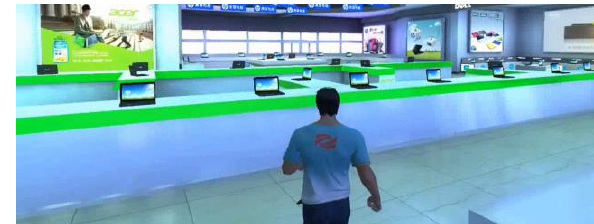
Figure 2. Using C# stream to write users’ data